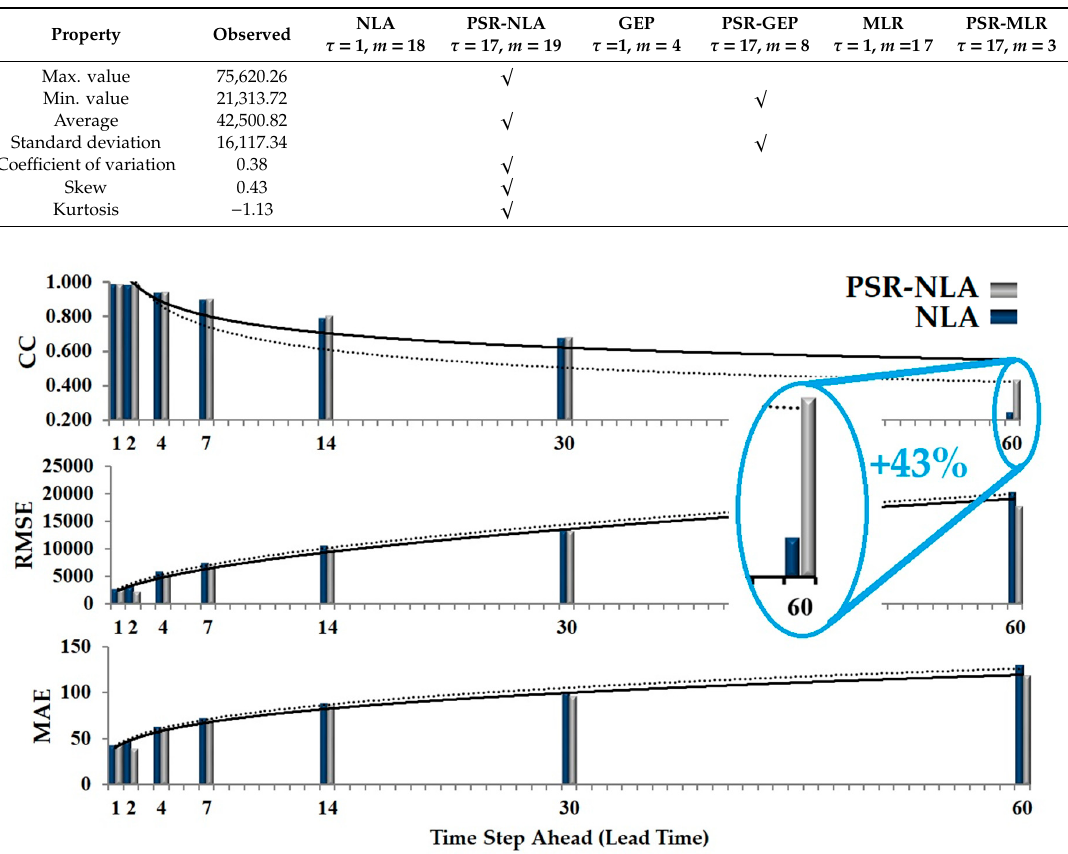
Figure 9. Performance of NLA and PSR-NLA in time ahead forecasting by the fitness functions of Correlation Coefficient (CC); Root Mean Square Error (RMSE); Mean Absolute Error (MAE) for lead time of 1-, 2-, 4-, 7-, 14-, 30- and 60-days.